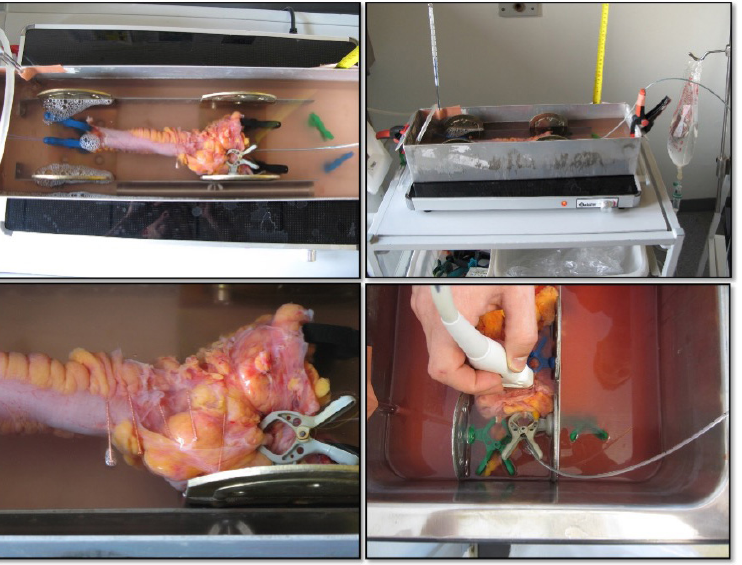
Figure 2. Experimental setup. Water container with oxygenated Krebs solution and the specimen stretched to original length using magnetic clamps ( top left ). The water container was placed on a table heater (37 ◦ C) with a ruler and bag for applying pressure ( top right ). Acupuncture needles inserted as location markers for ultrasound ( bottom left ). Ultrasound probe during scanning the bowel segment (bottom right).